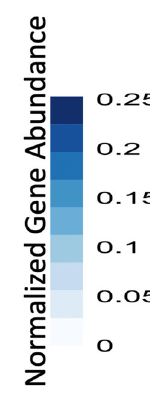
Fig. 3 Metagenome analysis of selected hydrocarbon catabolic genes. Gene abundances are normalized to single copy marker gene ( rpoB ) abundance for each sample. Numbers correspond to genes associated with metabolic reactions indicated in Fig.